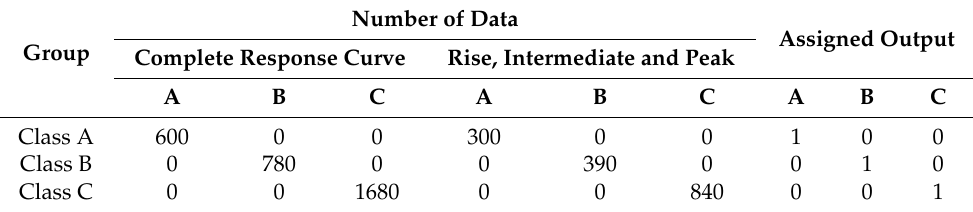
Table 5. Size of the training dataset for each of the 13 measurement sensors, at different extracted signals, by using an Artificial Neural Network